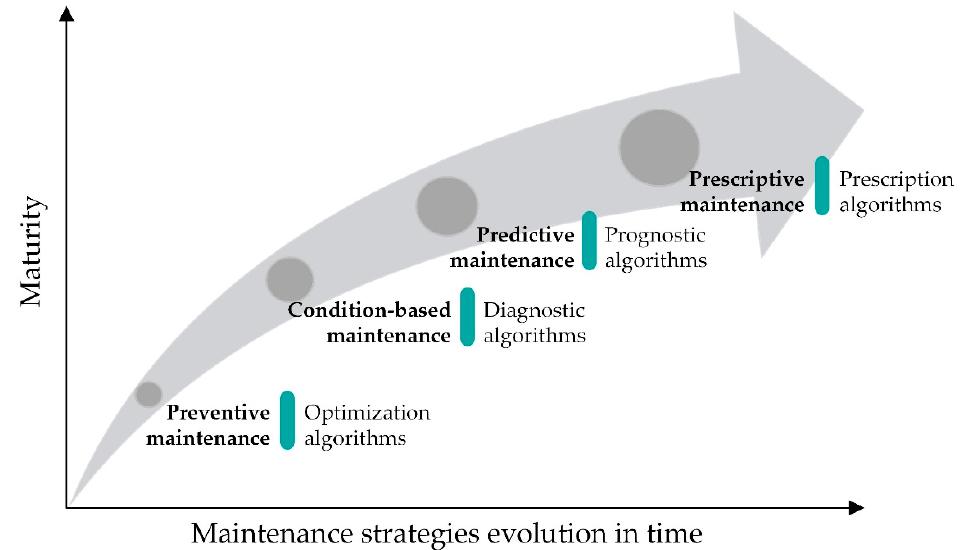
Figure 1. Knowledge-based maintenance evolution.